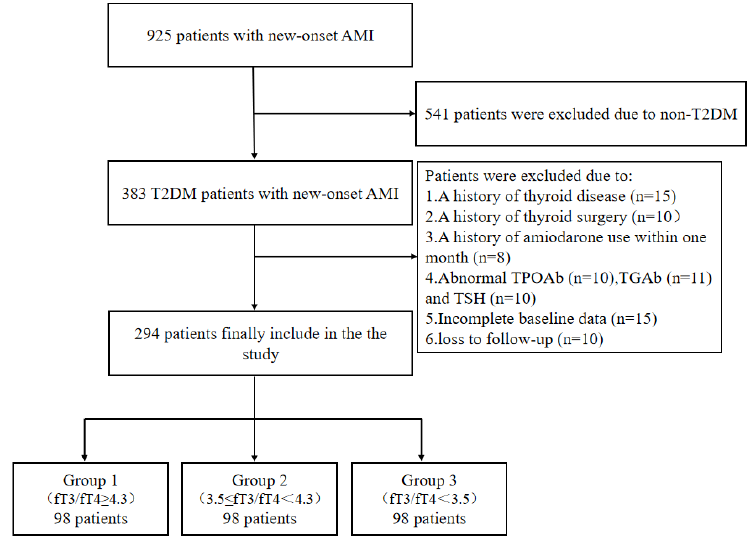
Figure 1. Study flowchart.